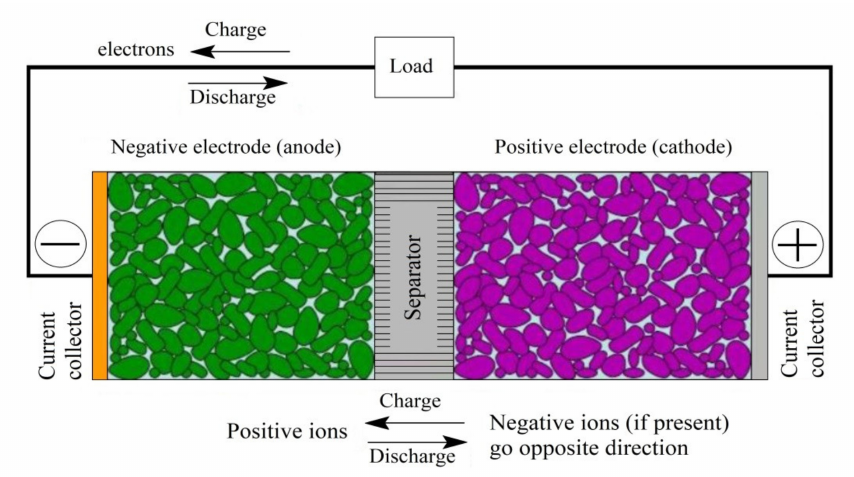
Figure 1. Detailed structure of the interior of an electrochemical cell of a lithium ion (Li-ion) battery. Li + ions move around inside the cell, and the electrons detached from the oxidation reaction electrons are available and then stored in the electrodes as shown in Equation (2)